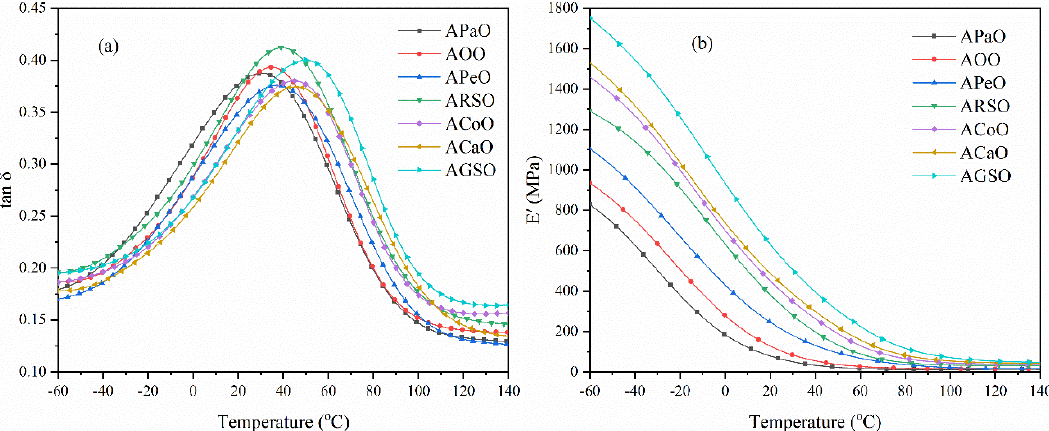
Figure 3. ( a ) Loss factor and ( b ) storage modulus of the UV-cured films. Table 2. Dynamic mechanical properties and cross-linking density of the UV-cured films. Samples